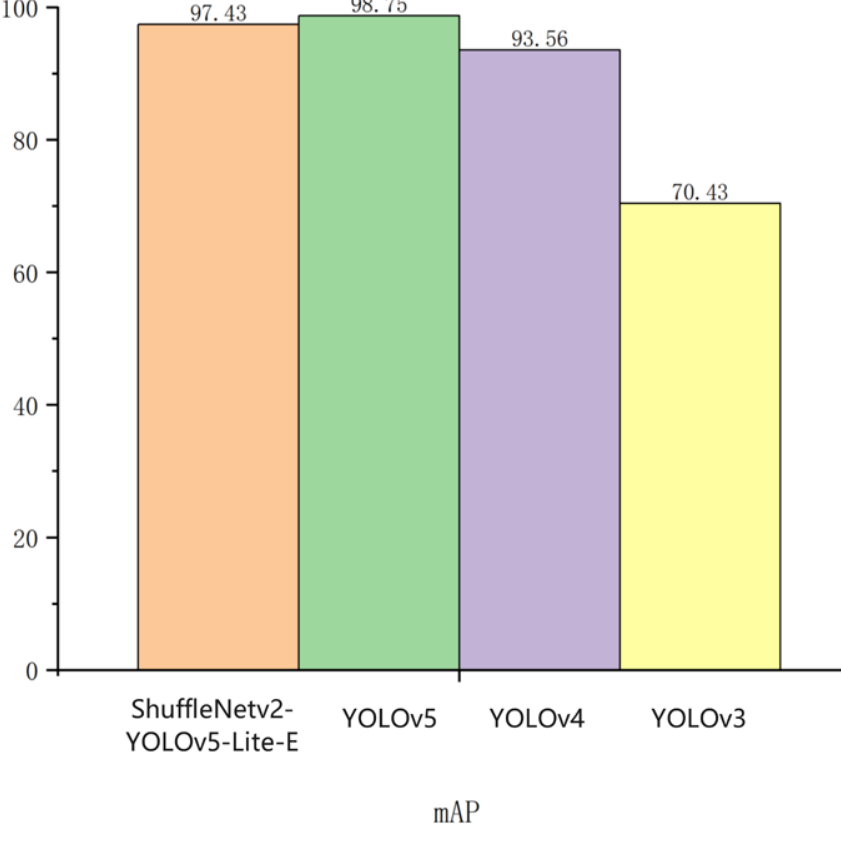
Table 1. Model size and recognition rate.